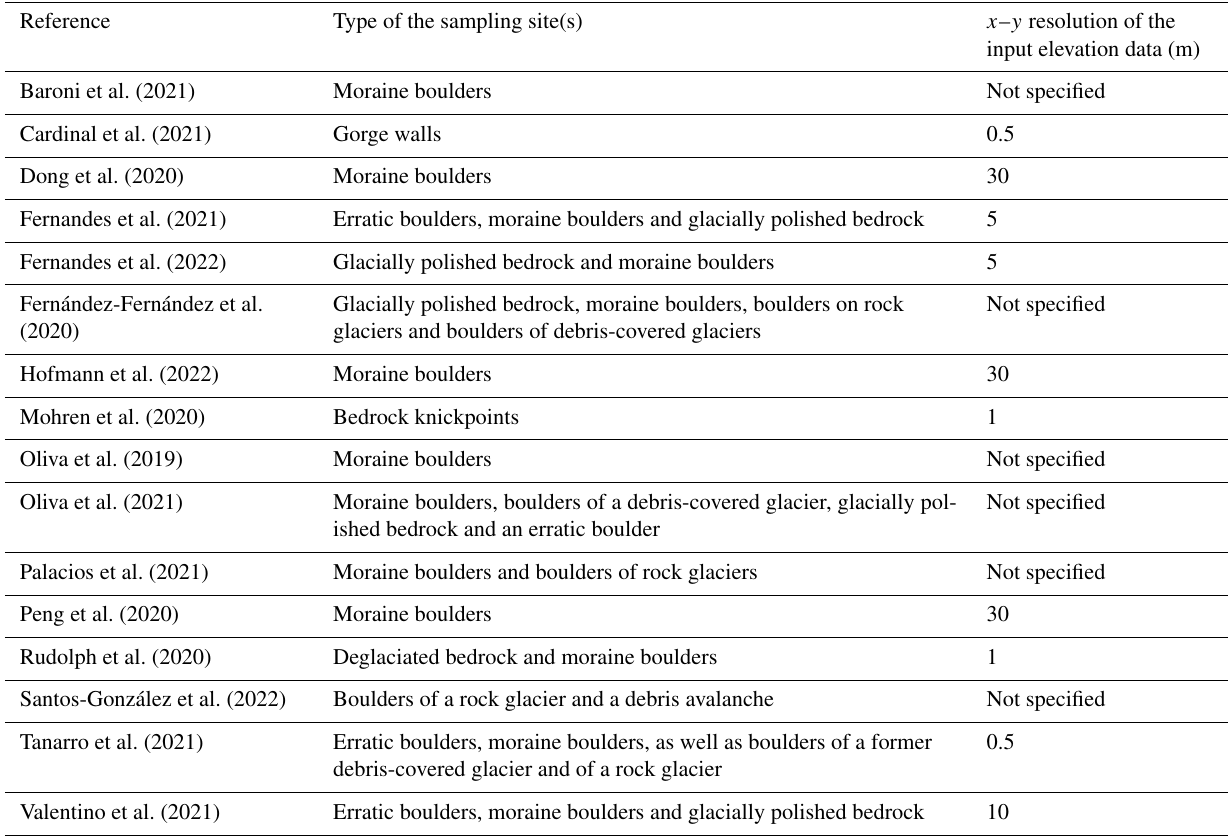
Table 1. Application of the ArcGIS toolbox of Li (2018) in previous studies.